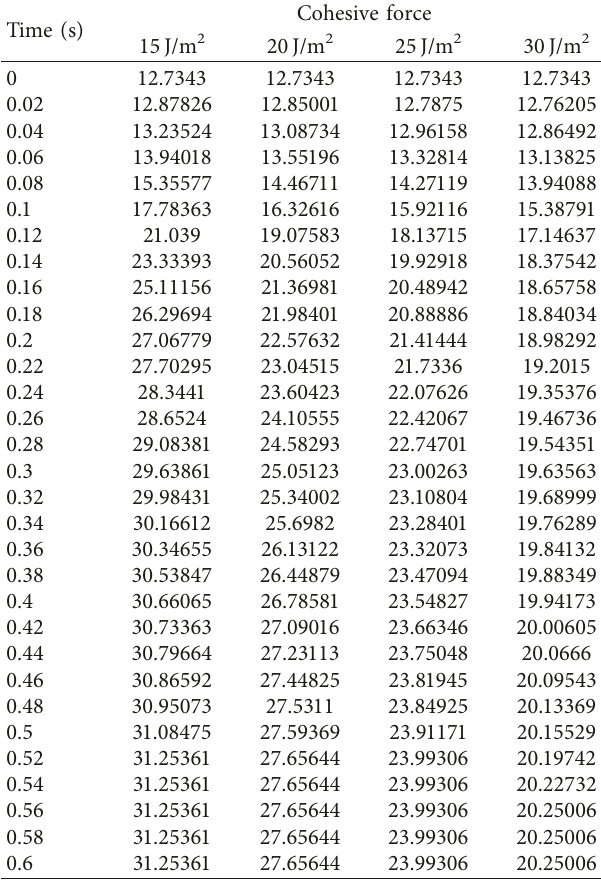
Figure 6: Time-dependent change curves of mass loss rates under different cohesive forces. Table 4: Porosity coefficients under different cohesive forces.